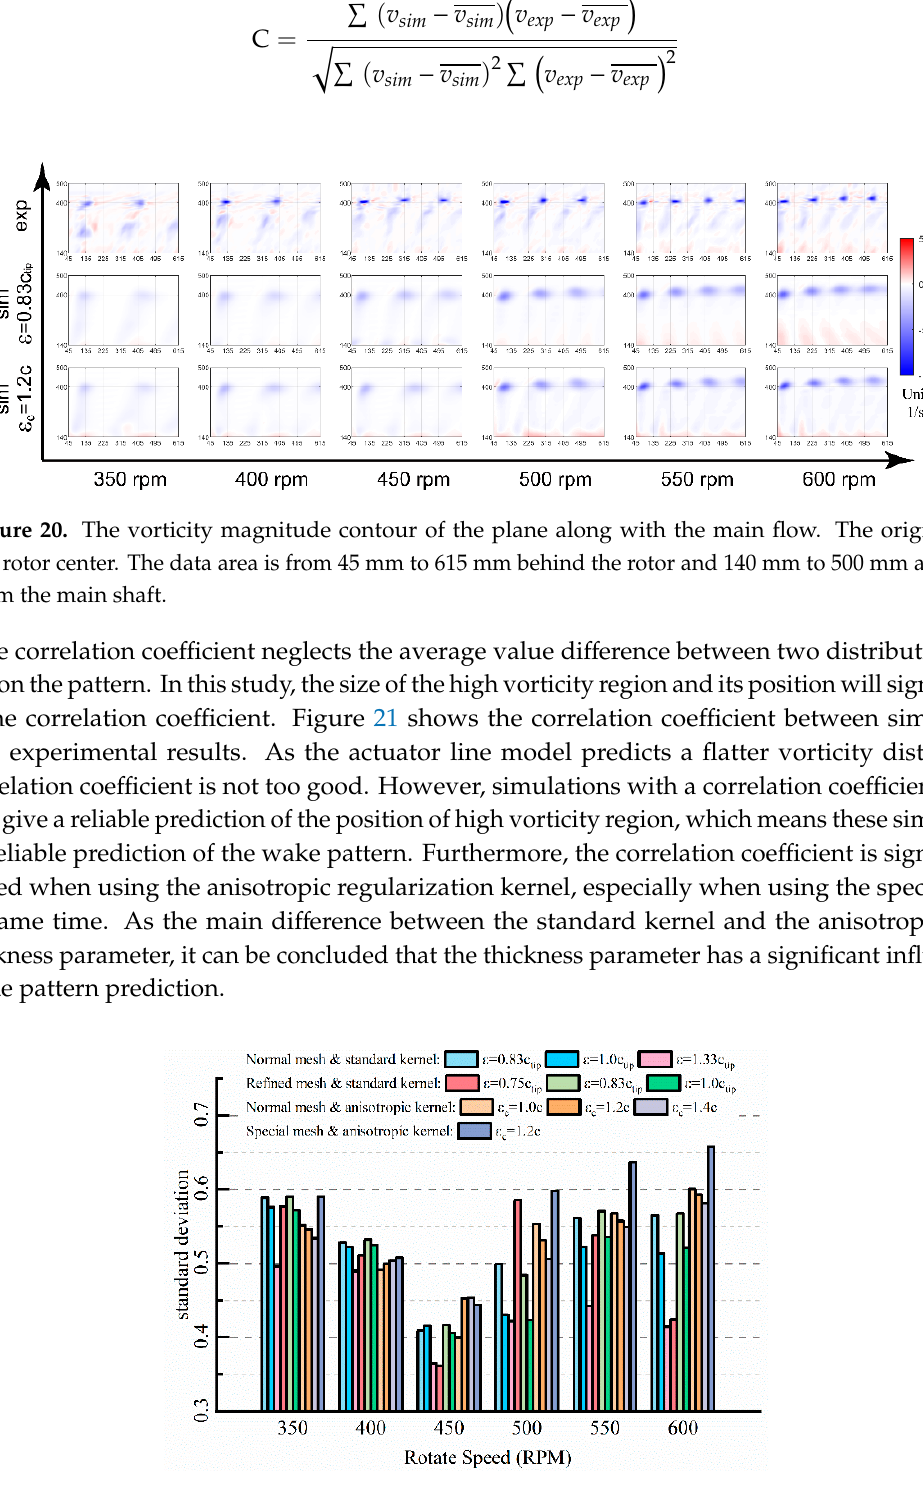
Figure 21. The comparison of the correlation coefficient.